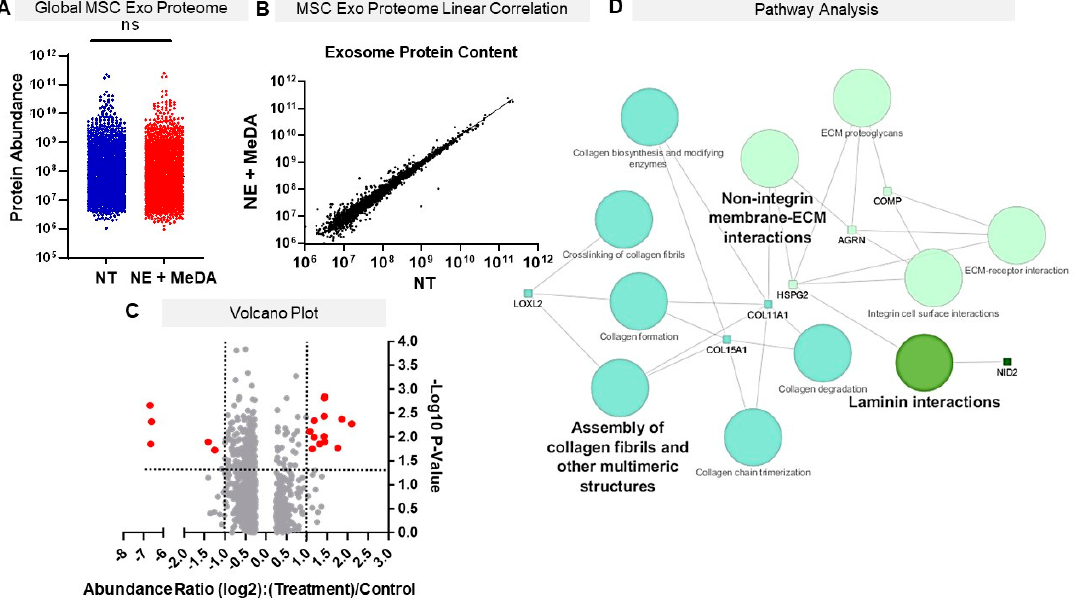
Figure 6. Proteomic profile of MSC exosomes 48h after norepinephrine and N-methyldopamine (NE + MeDA) treatment. ( A ) Raw abundance values from the NT and NE + MeDa groups showed no statistical difference using a paired t-test across samples. ( B ) Linear regression analysis comparing non-treated MSCs (NT) and MSCs treated with NE + MeDA. ( C ) Data visualized using a volcano plot with red dots indicating statistically significantly different proteins with an abundance change of 2-fold or higher. ( D ) Cytoscape 3.2.1 visualization of Kegg, Reactome, and Panther Pathway hits of differentially expressed proteins using ClueGo v.2.5.4. The font size is mapped to the p value with Bonferroni step down correction, and the node size is mapped to number of statistically significant gene hits.